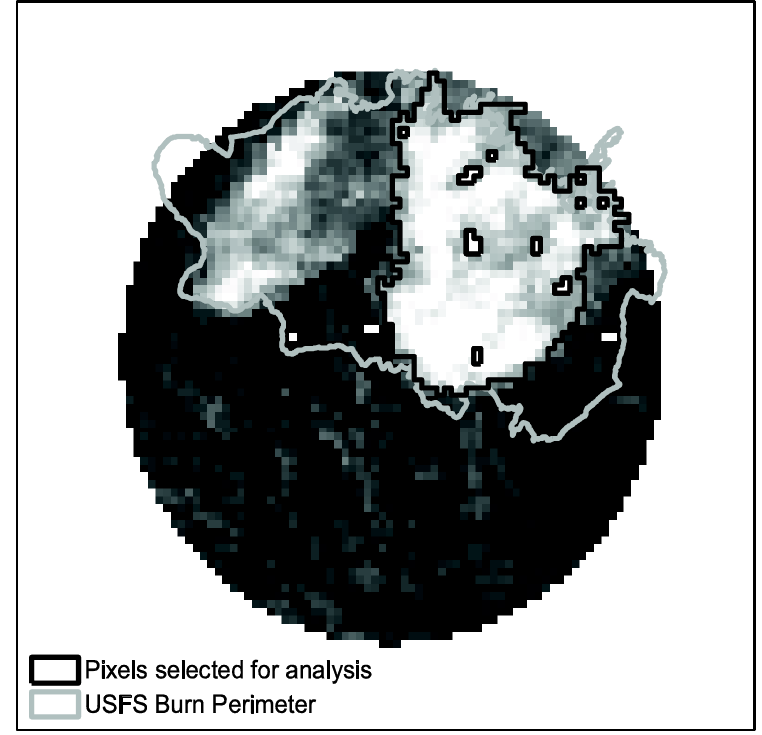
Figure 8. Rodeo-Chediski fire burned perimeter (gray) as defined by the US Forest Service, compared to the area identified for analysis (black), overlaid on the search area of 1km 2 z-score pixels, as calculated using formula 1. This highlights the challenge of using the z-score threshold to identify a burned area precisely for areas burned at lower